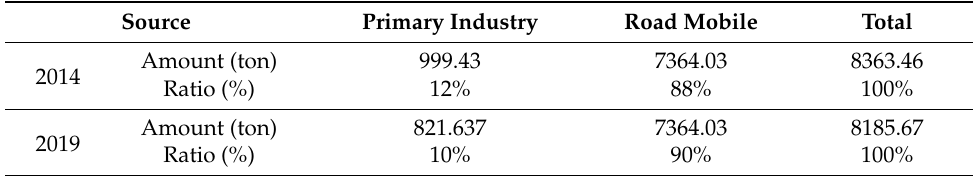
Table 4. NH 3 emissions in Shenzhen in 2014 and